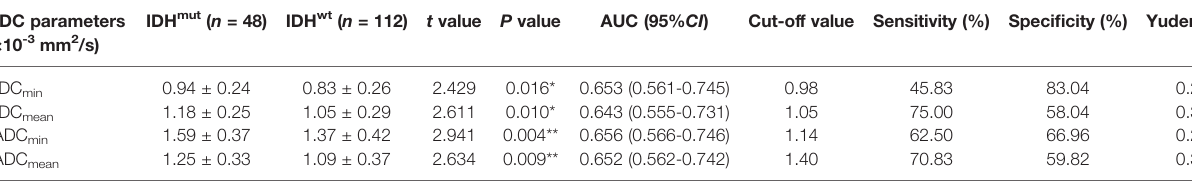
TABLE 5 | Comparison and ROC curve analysis of ADC parameters between IDH mut and IDH wt gliomas. ADC parameters (×10 -3 mm 2 /s)